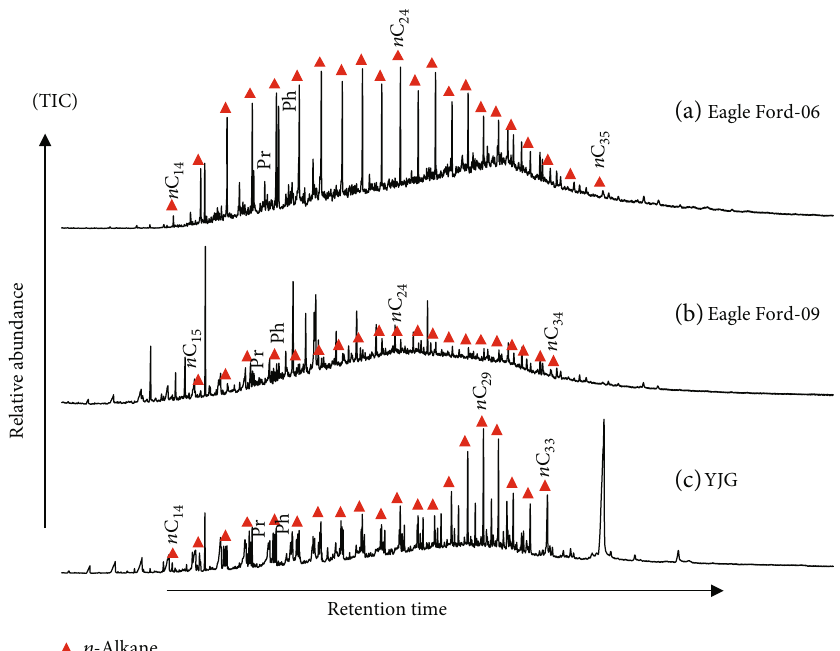
Figure 4: Total ion chromatograms of the organic compounds in diethyl ether ((a) Eagle Ford-06, (b) Eagle Ford-09, and (c) YJG).